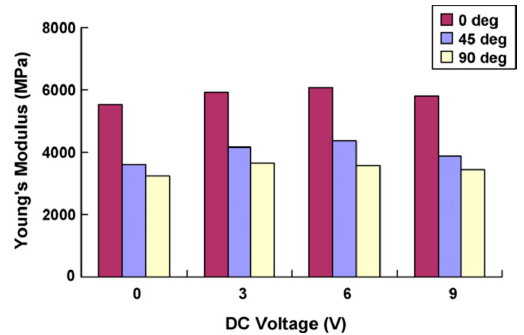
Figure 2. Variation of elastic modulus with electric excitation [31].